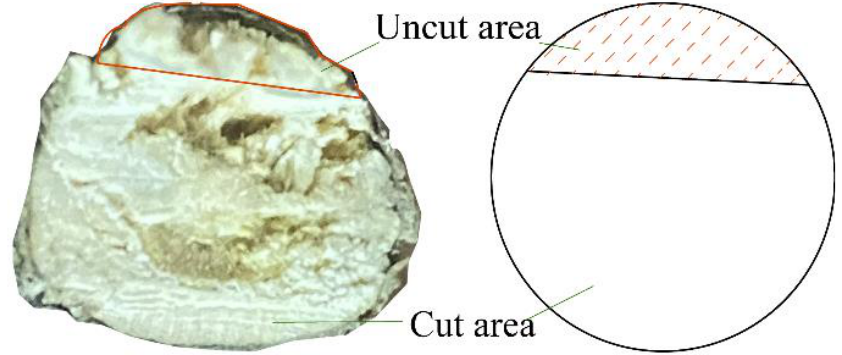
Figure 8. Cutting quality diagram.